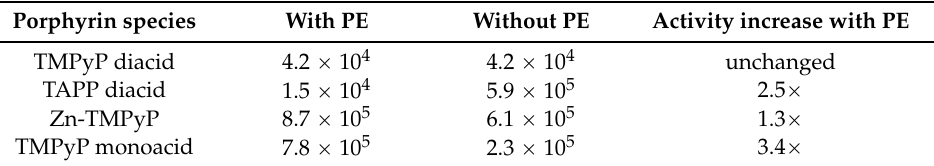
Table 3. Generated concentrations of triiodide